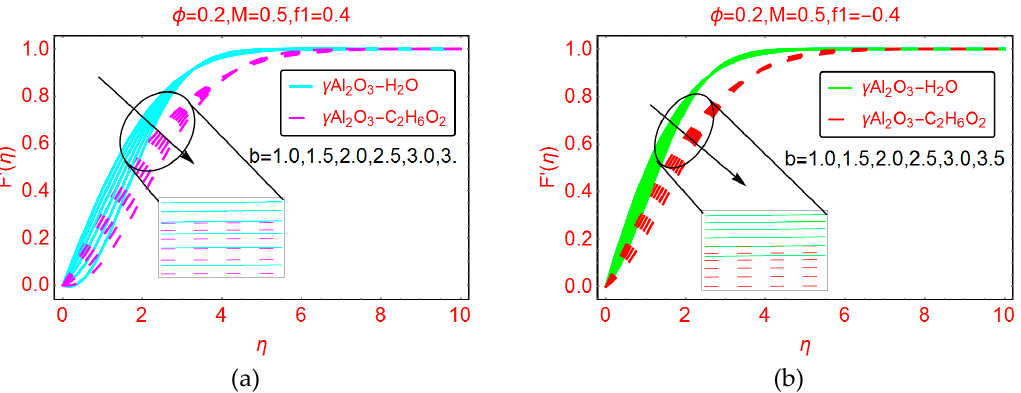
Figure 2. E ff ects of b on the velocity profile F (cid:48) ( η ) for ( a ) f 1 = 0.4 and ( b ) f 1 = − 0.4. Figure 2. Effects of 𝑏 on the velocity profile 𝐹′(𝜂) for ( a ) 𝑓1 = 0.4 and ( b ) 𝑓1 = −0.4